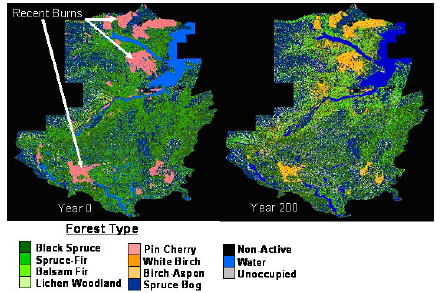
LANDIS-II (Scheller et al. 2007; http://landis.forest.wisc.edu) is a recent elaboration of